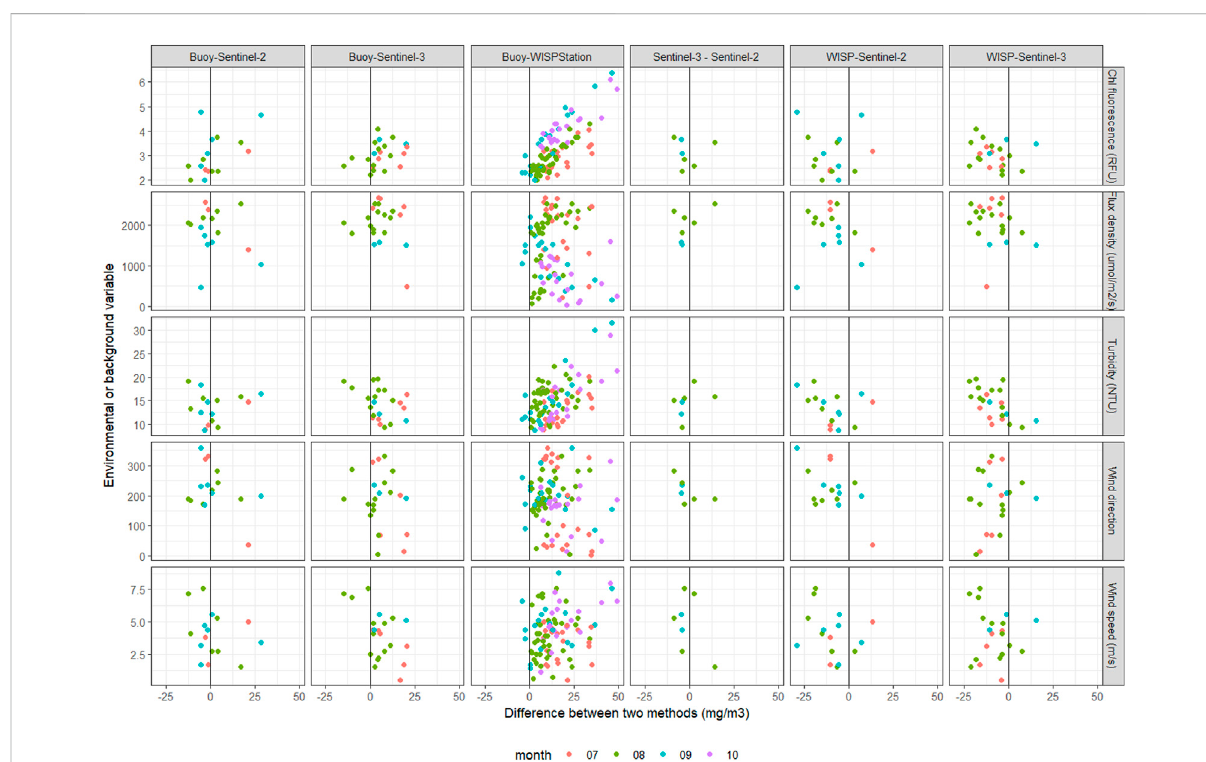
FIGURE 4 Impact of environmental and background conditions to method-based differences in estimating C Chl-a in Lake